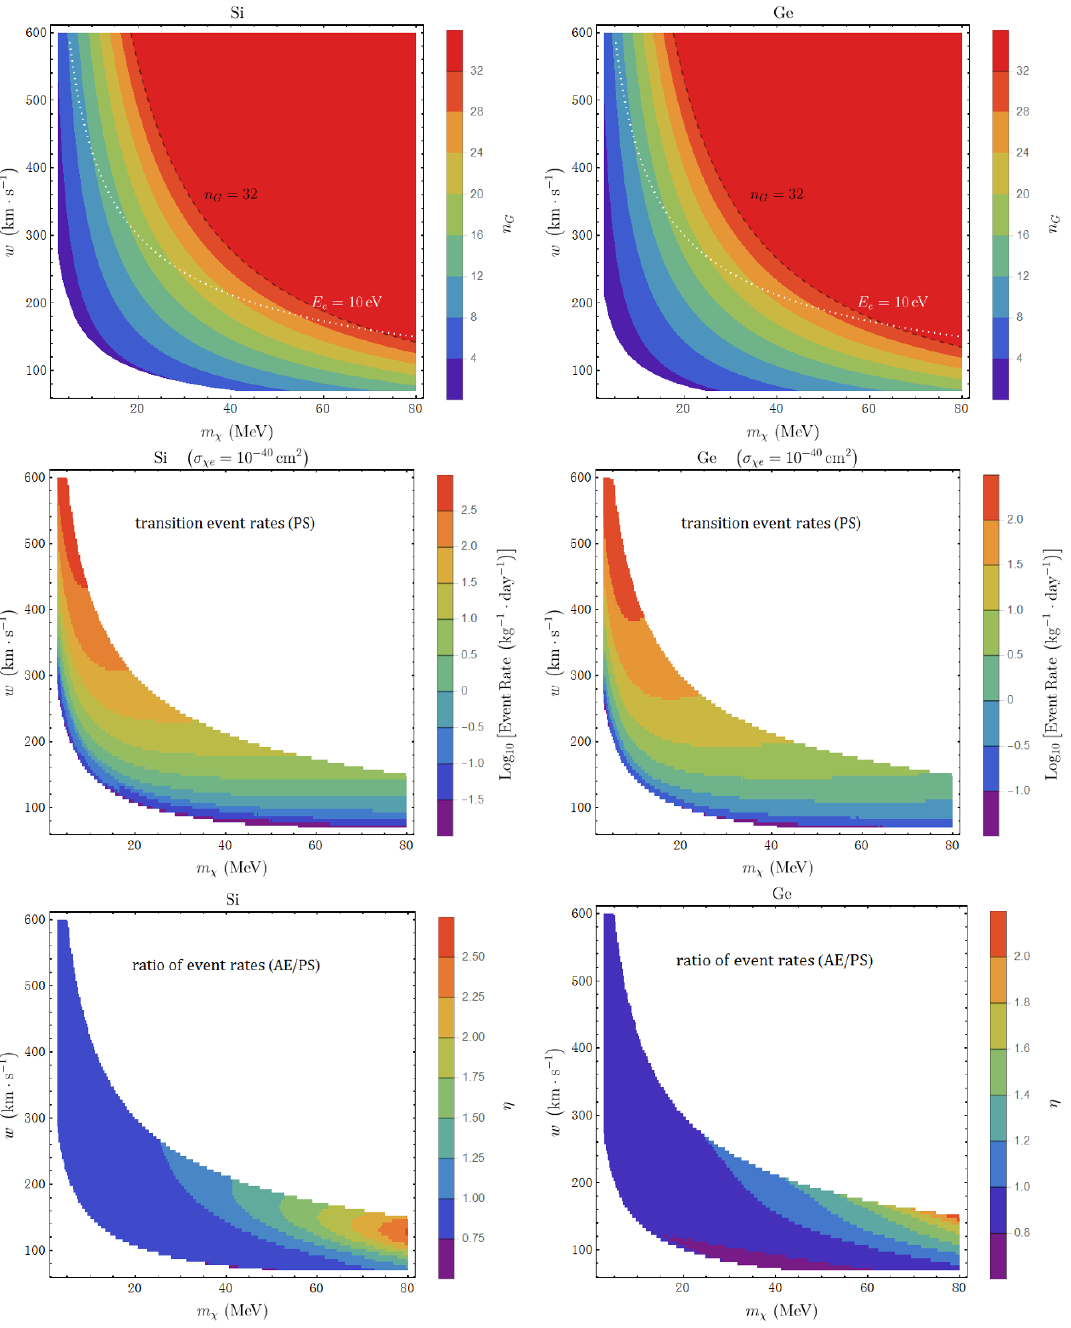
Figure 5 . Upper: the maximum modulus number of the reciprocal G -vectors involved in the DM- induced transition events for parameters ( m χ , w ), for silicon ( left ), and germanium ( right ). The black dashed lines mark the truncation n G 32 imposed by the grid resolution in the real space, ≤ while the white dotted lines represent the transition energy bound E e = 10 eV adopted in this work. Middle: the calculated DM-induced transition events for silicon ( left ), and germanium ( right ), for a DM-electron cross section σ χe = 10 − 40 cm 2 . Bottom: ratios of the AE event rate to the PS event rate for silicon ( left ) and germanium ( right ), respectively. See text for